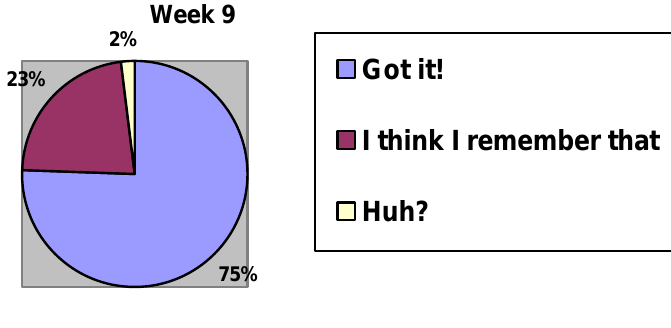
Figure 13. Student Comprehension Checklist compiled during the ninth week of the implementation of posting and communicating daily learning